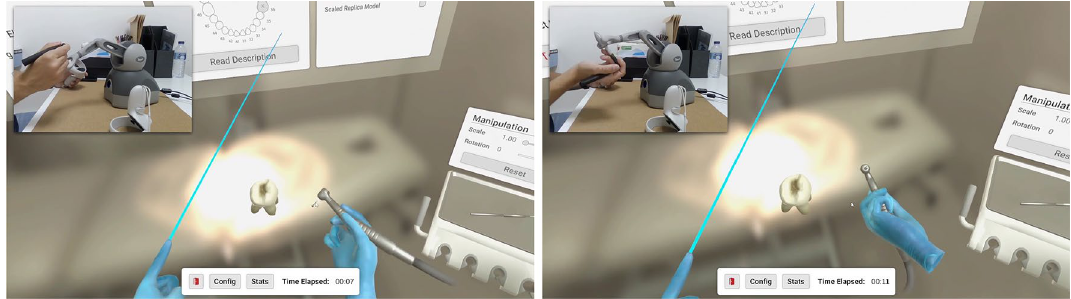
Figure 2. Haptic Pen and VR Controller combined workflow: using the haptic pen with their dominant hand, the user moves the drill, feeling force feedback and vibration. With their other hand, the user holds a regular VR controller that can be used to manipulate the environment, interact with the UI or operate auxiliary tools.